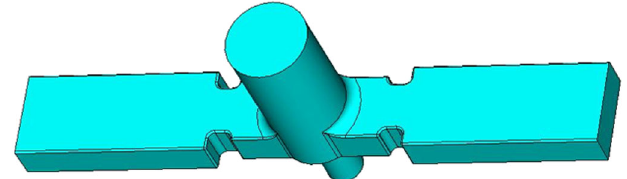
FIG. 3. (Color) The mode launcher geometry converting the waveguide mode into the circular TM 01 mode at a match better than (cid:1) 45 dB .